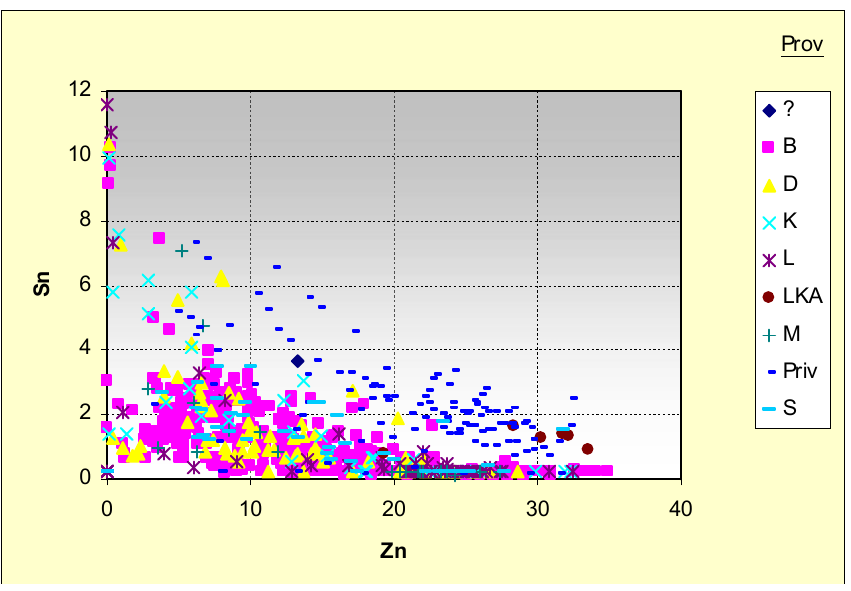
Figure 8. Tin content (M%) as a function of zinc content (M%) determined by atomic absorption spectrometry (AAS) for bronze and brass objects of presumable and certain Benin provenance (Rathgen Research Laboratory Database. B,D,K,L,M,S: public museum collections, Priv: private collectors, LKA: group of investigated objects).